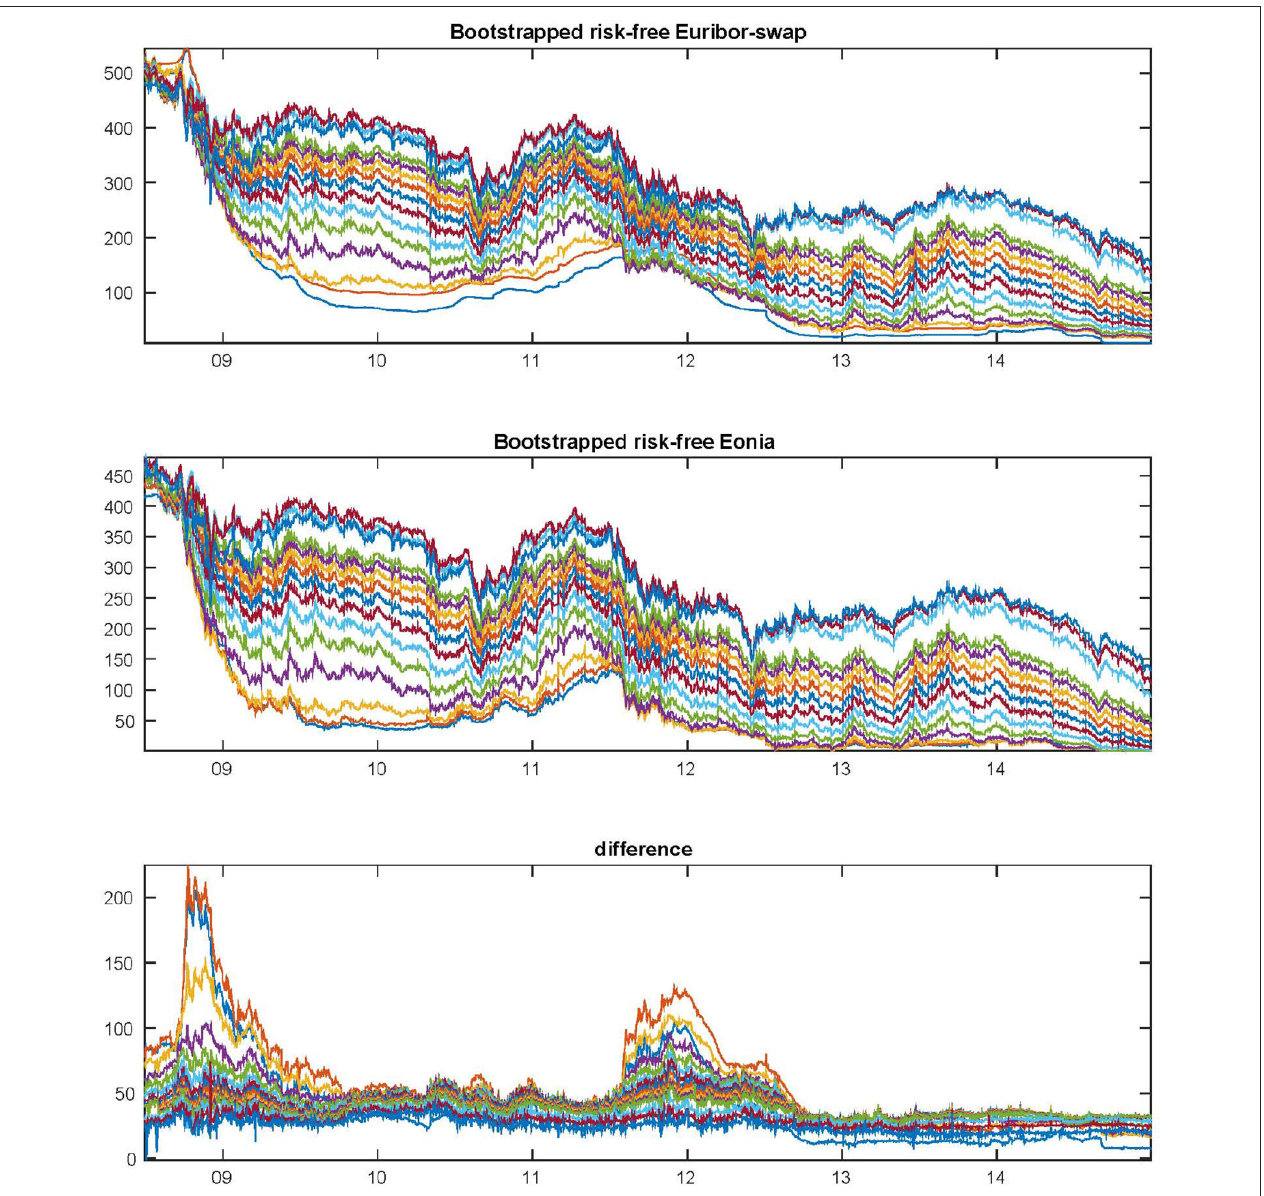
FIGURE 1 | Bootstrapped zero rates form the Euribor and swap curve and Eonia swap curve from June 30, 2008 to December 31, 2014. The zero rates and their difference range from the 3-month to the 30-year maturity.